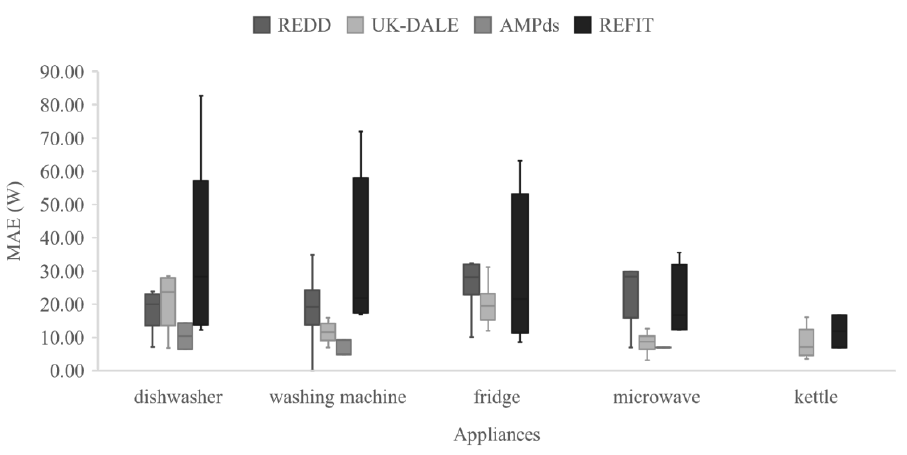
Figure 10. Minimum and maximum MAE error performance achieved for the top-5 commonly used appliances.